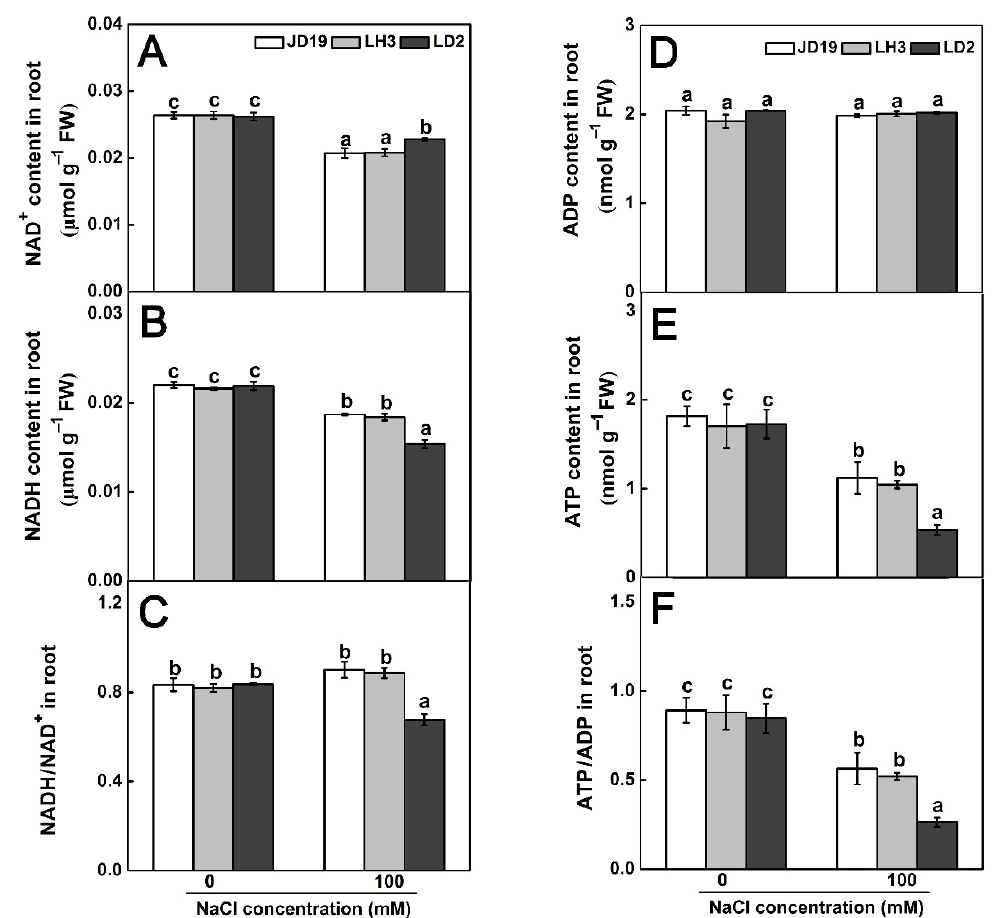
Figure 10. Effects of salt stress on NAD + content ( A ), NADH content ( B ), NADH/NAD + ratio ( C ), ADP content ( D ), ATP content ( E ), and ATP/ADP ratio ( F ) of three soybean cultivars. Data are means ± SE ( n = 3). Different letters indicate significant difference at p < 0.05.